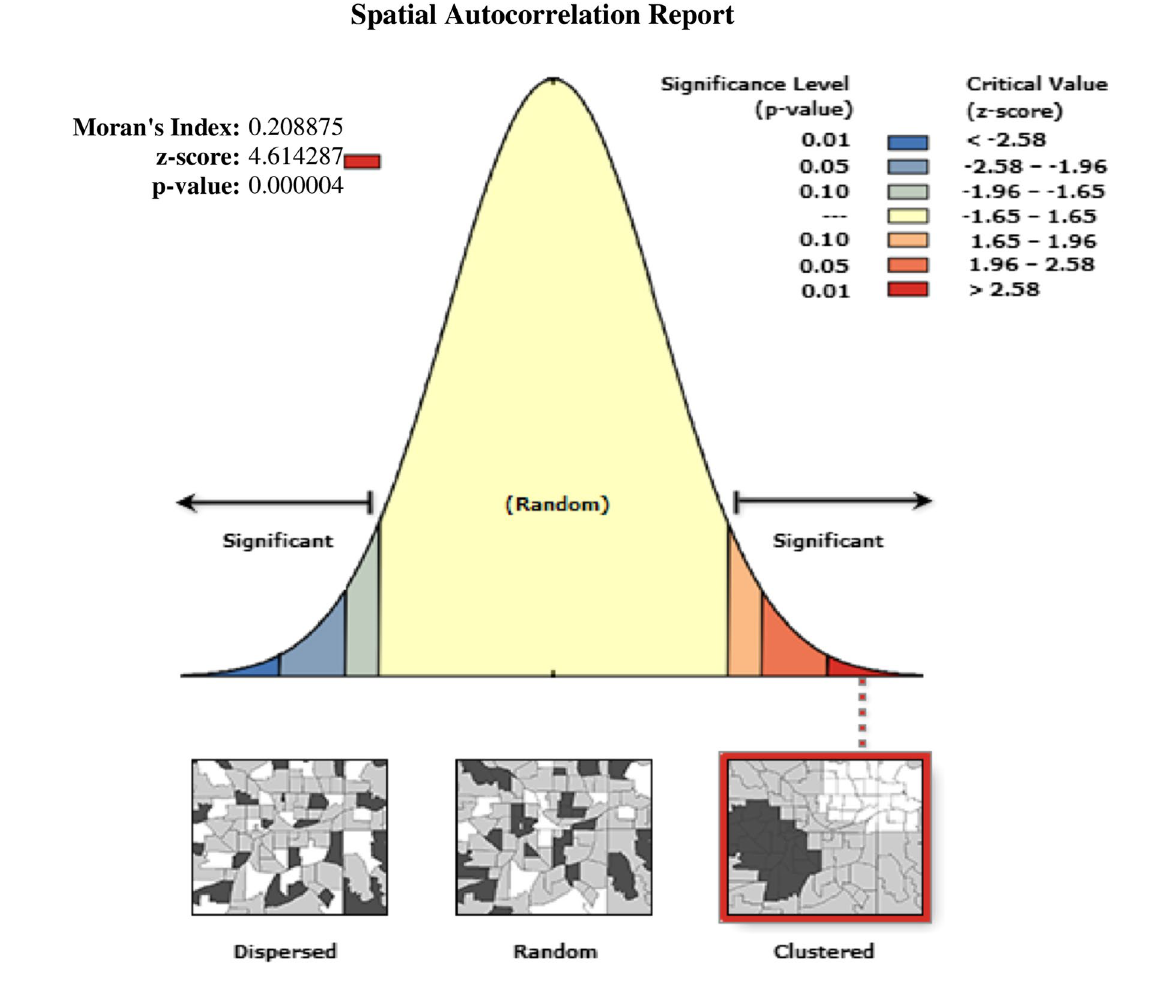
Fig. 2 Spatial autocorrelation analysis of high-risk fertility behavior among reproductive-age women in Ethiopia, 2019 Ethiopian Demographic and Health